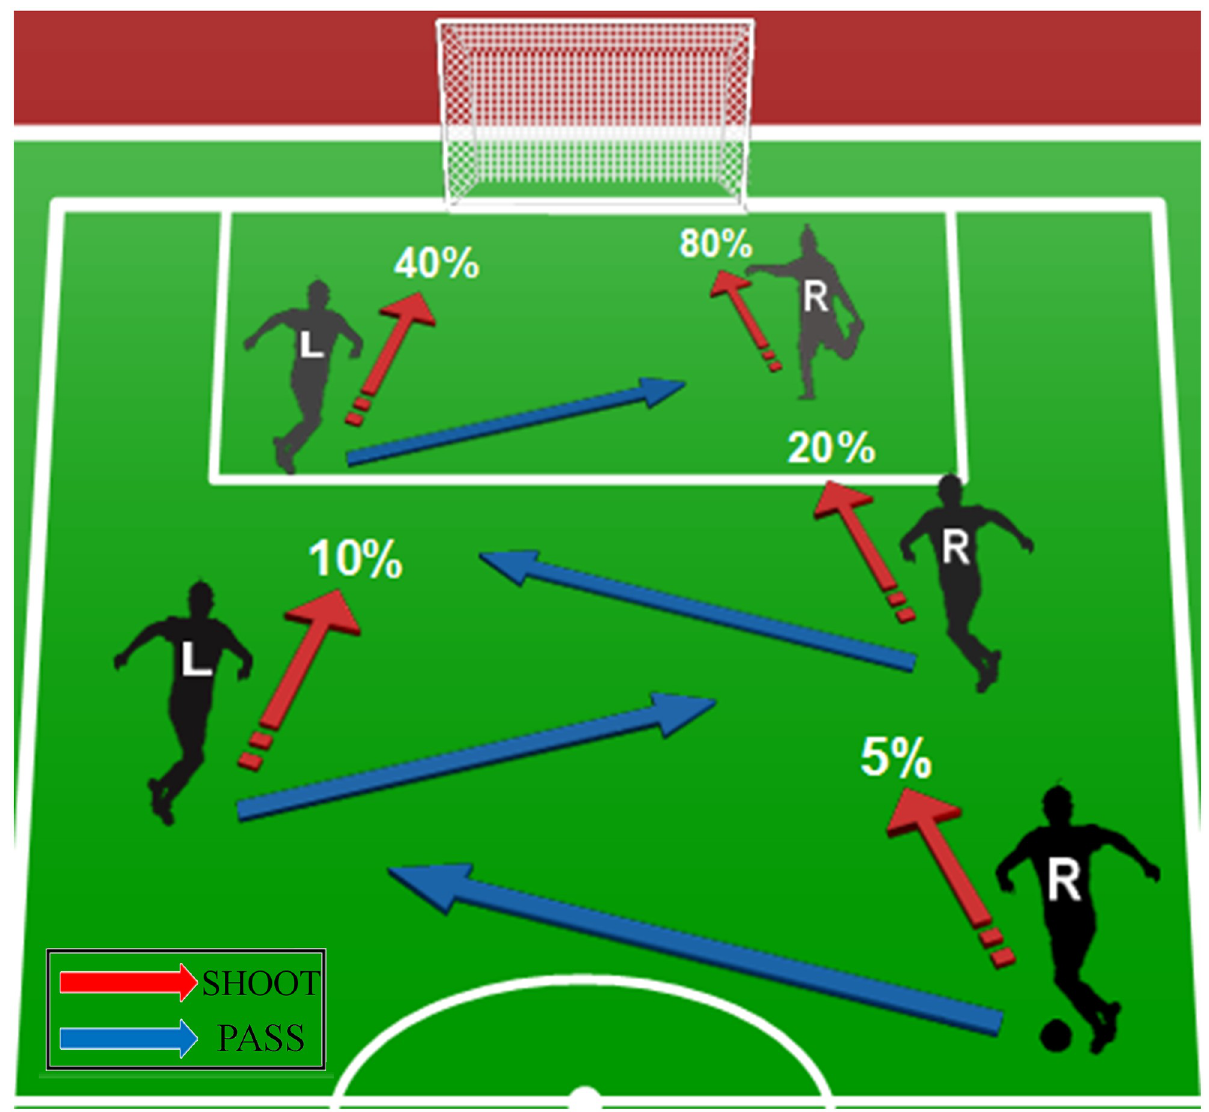
Fig 3. Illustration of the centipede game framed as a game of soccer. Passing doubles the team’s chance of scoring a goal while shooting secures an individual the possibility to receive the higher payoff, which is € 160 for the scorer compared to only € 40 for the other player.